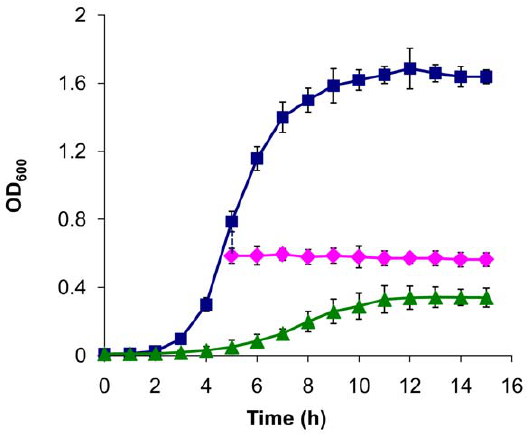
Figure 2. Growth of S.oneidensis strains at 30 6 C in LB medium under normal or osmotic stress conditions. Under normal condition (blue square), osmotic stress condition (20% sucrose) (green triangle), or grown in LB and then transferred to the osmotic shock condition (purple diamond). The growth curves are the average curves for at least three replicate samples and the error bars represent standard error of the mean (SEM).